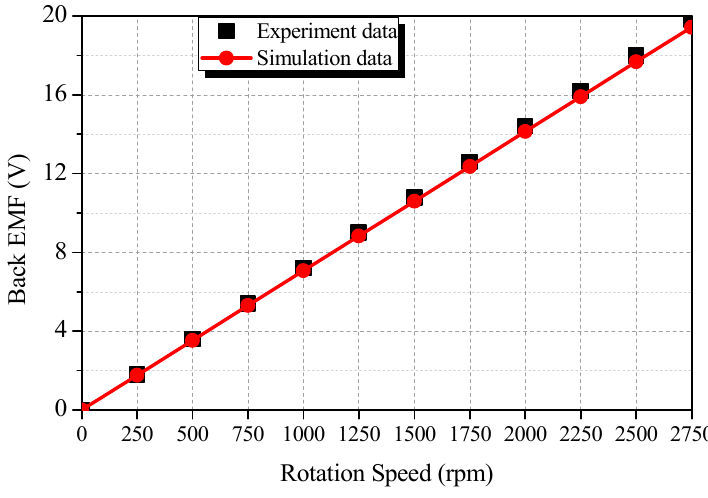
Figure 13. Back EMF for different rotating speeds.